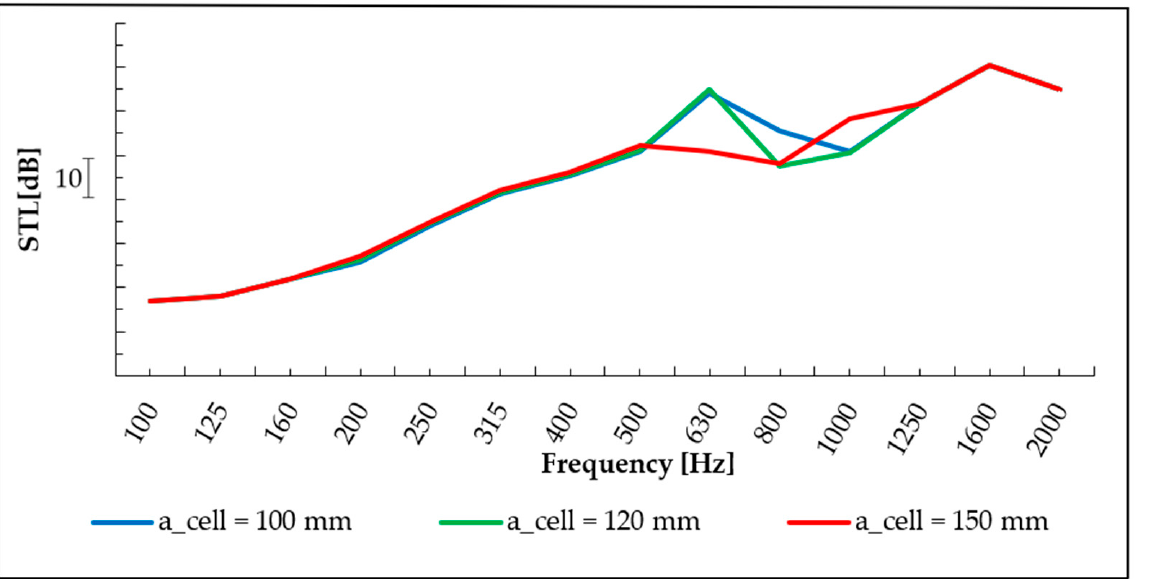
Figure 6. STL numerical results keeping the nominal dimensions for tck panel and h cell and varying a cell .